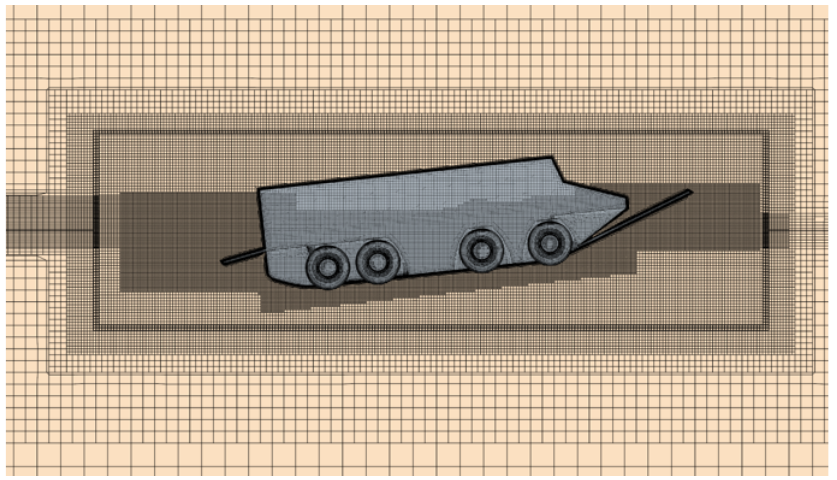
Figure 5. Grid distribution of the overset domain.